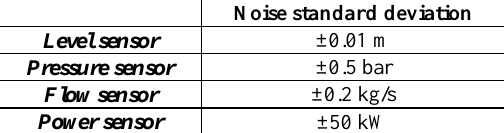
Table 3. Standard deviation of sensors